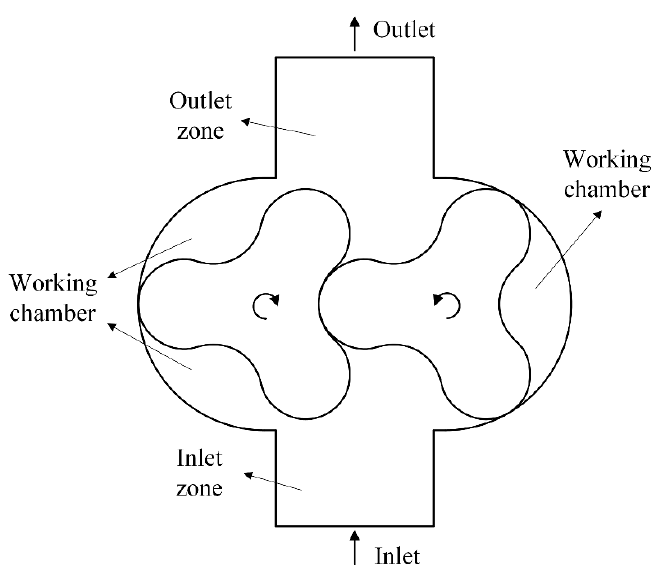
Figure 2. Flow domain of the Roots pump.